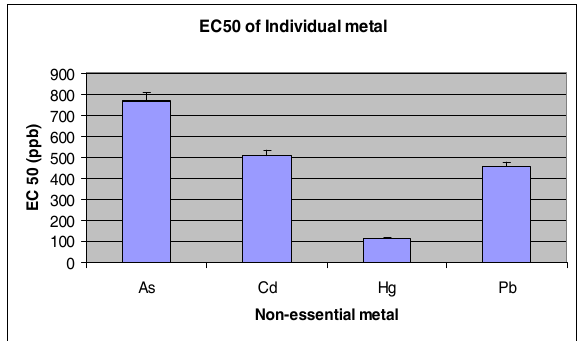
Figure 1: EC of metals tested individually 50 EC50 for Composite Mixture